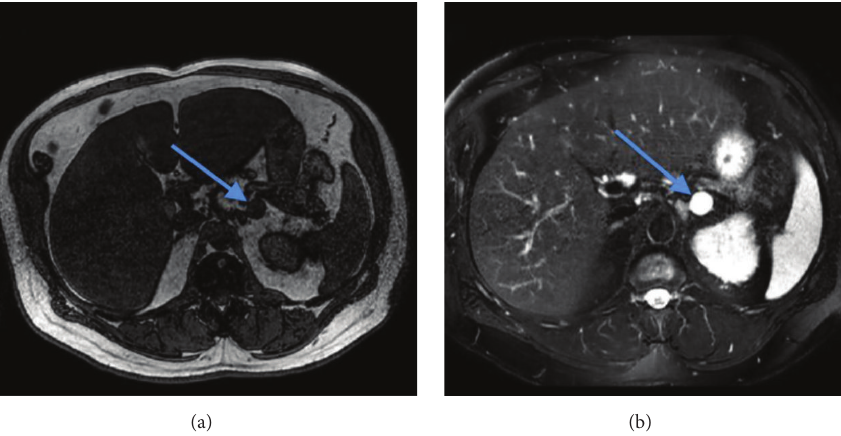
Figure 1: MRI of the adrenals. Within the lateral limb of the left adrenal gland, there is a 2.2 × 2.2 cm lesion (blue arrows) with uniformly high signal intensity on T2-weighted sequences (b) and low signal on T1-weighted images (a) with no significant loss of signal on opposed phase relative to in phase images.